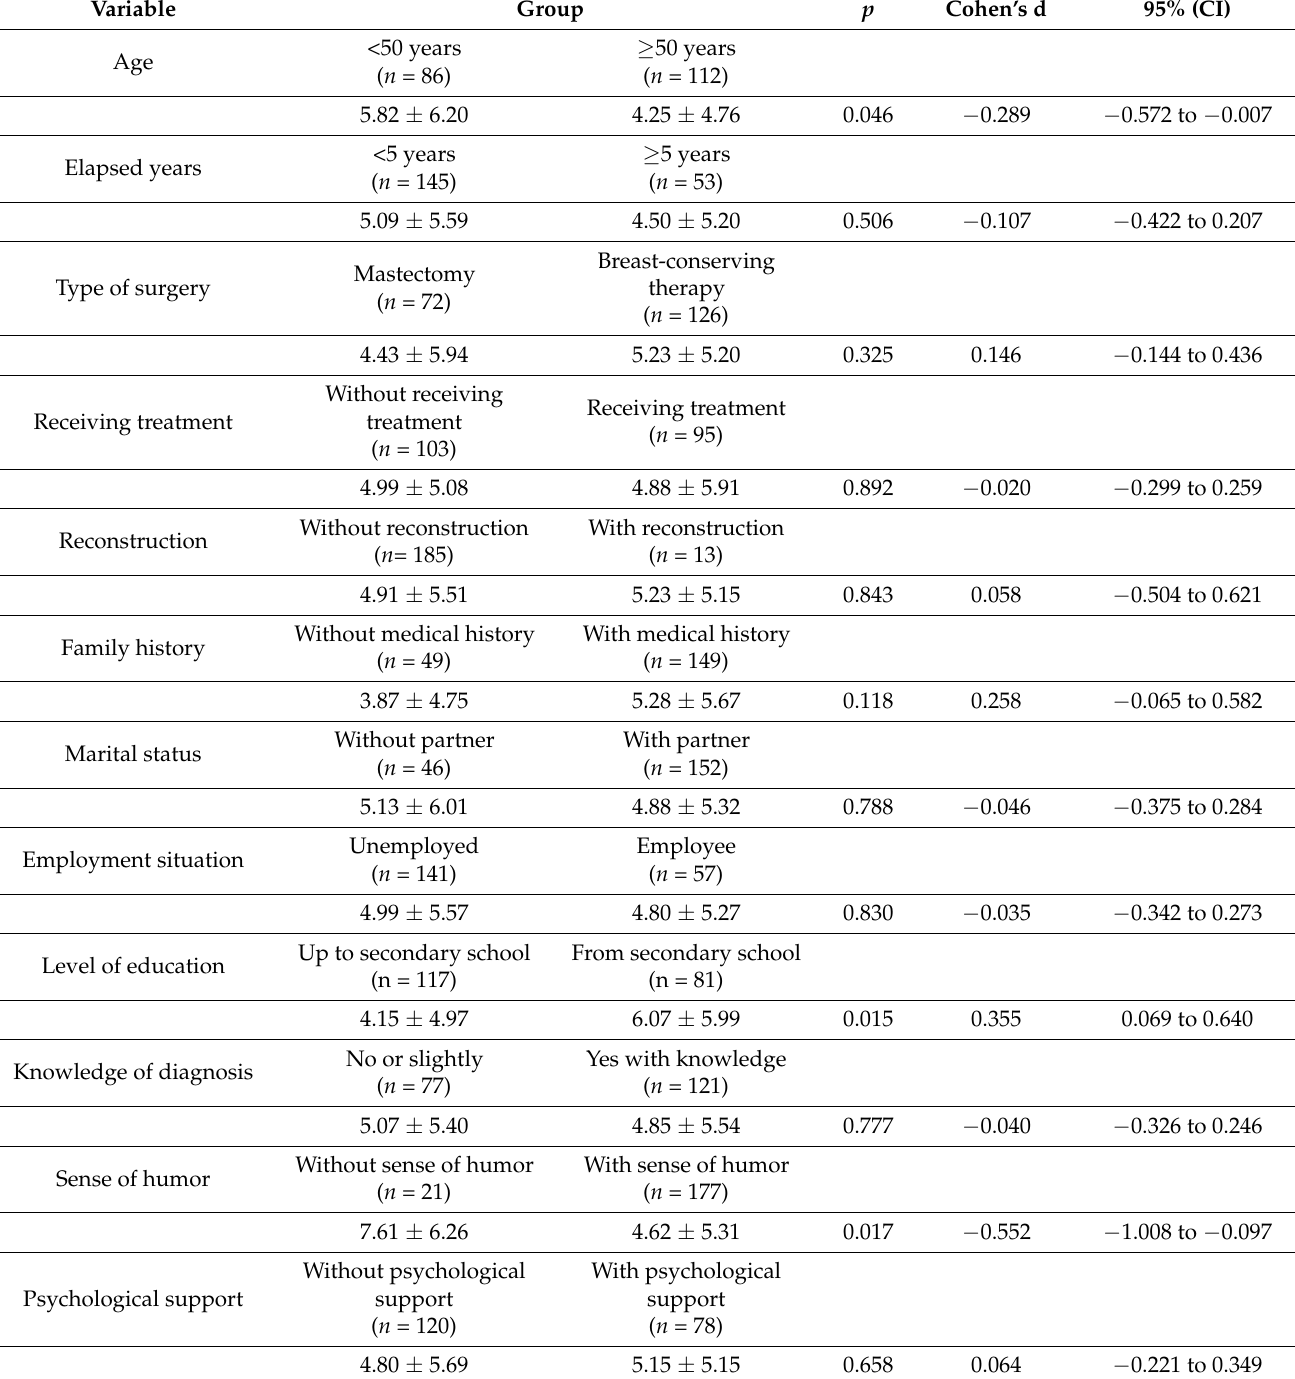
Table 1. Association between Characteristics and Body Image in Breast Cancer Survivors